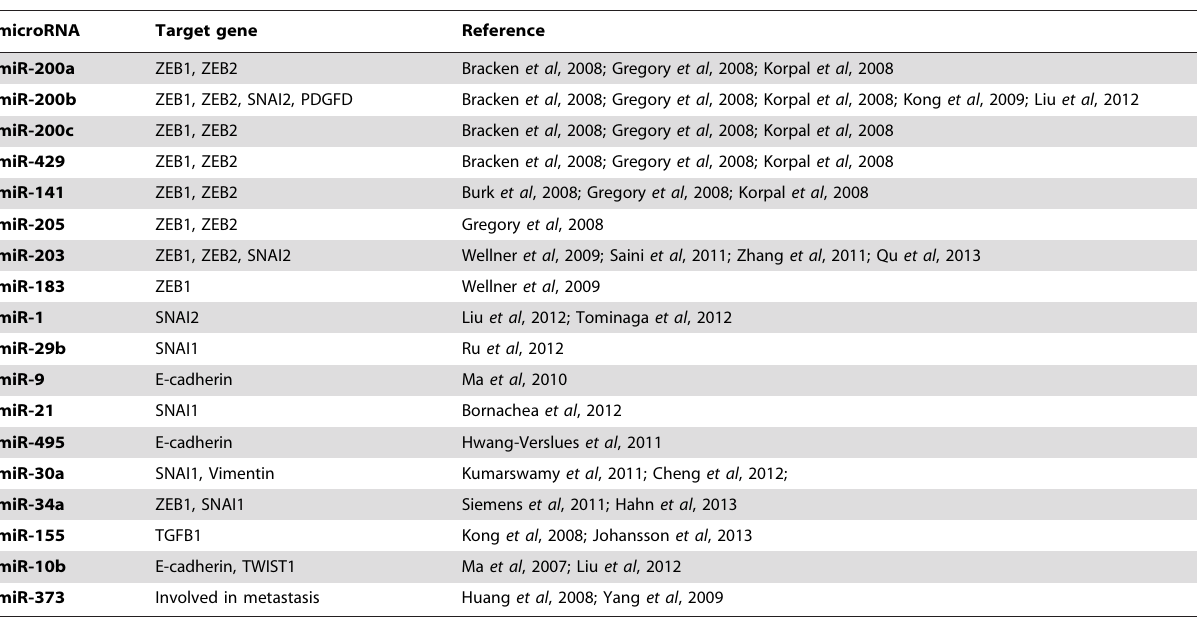
Table 1. Selection of miRNAs and their main